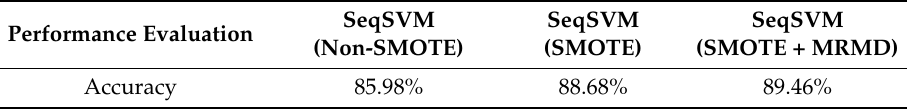
Table 2. The comparison of accuracy on SeqSVM